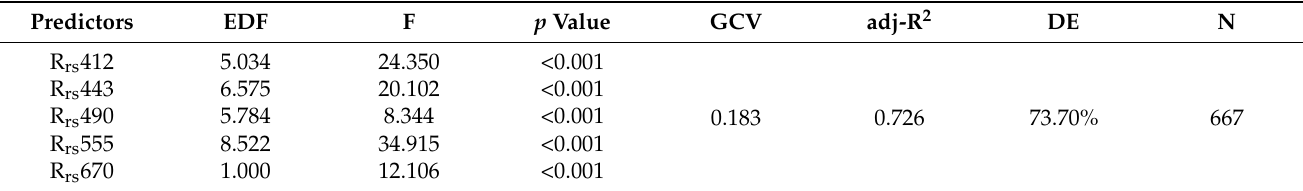
Table 7. Statistical summary of fitted dinoflagellates GAM.